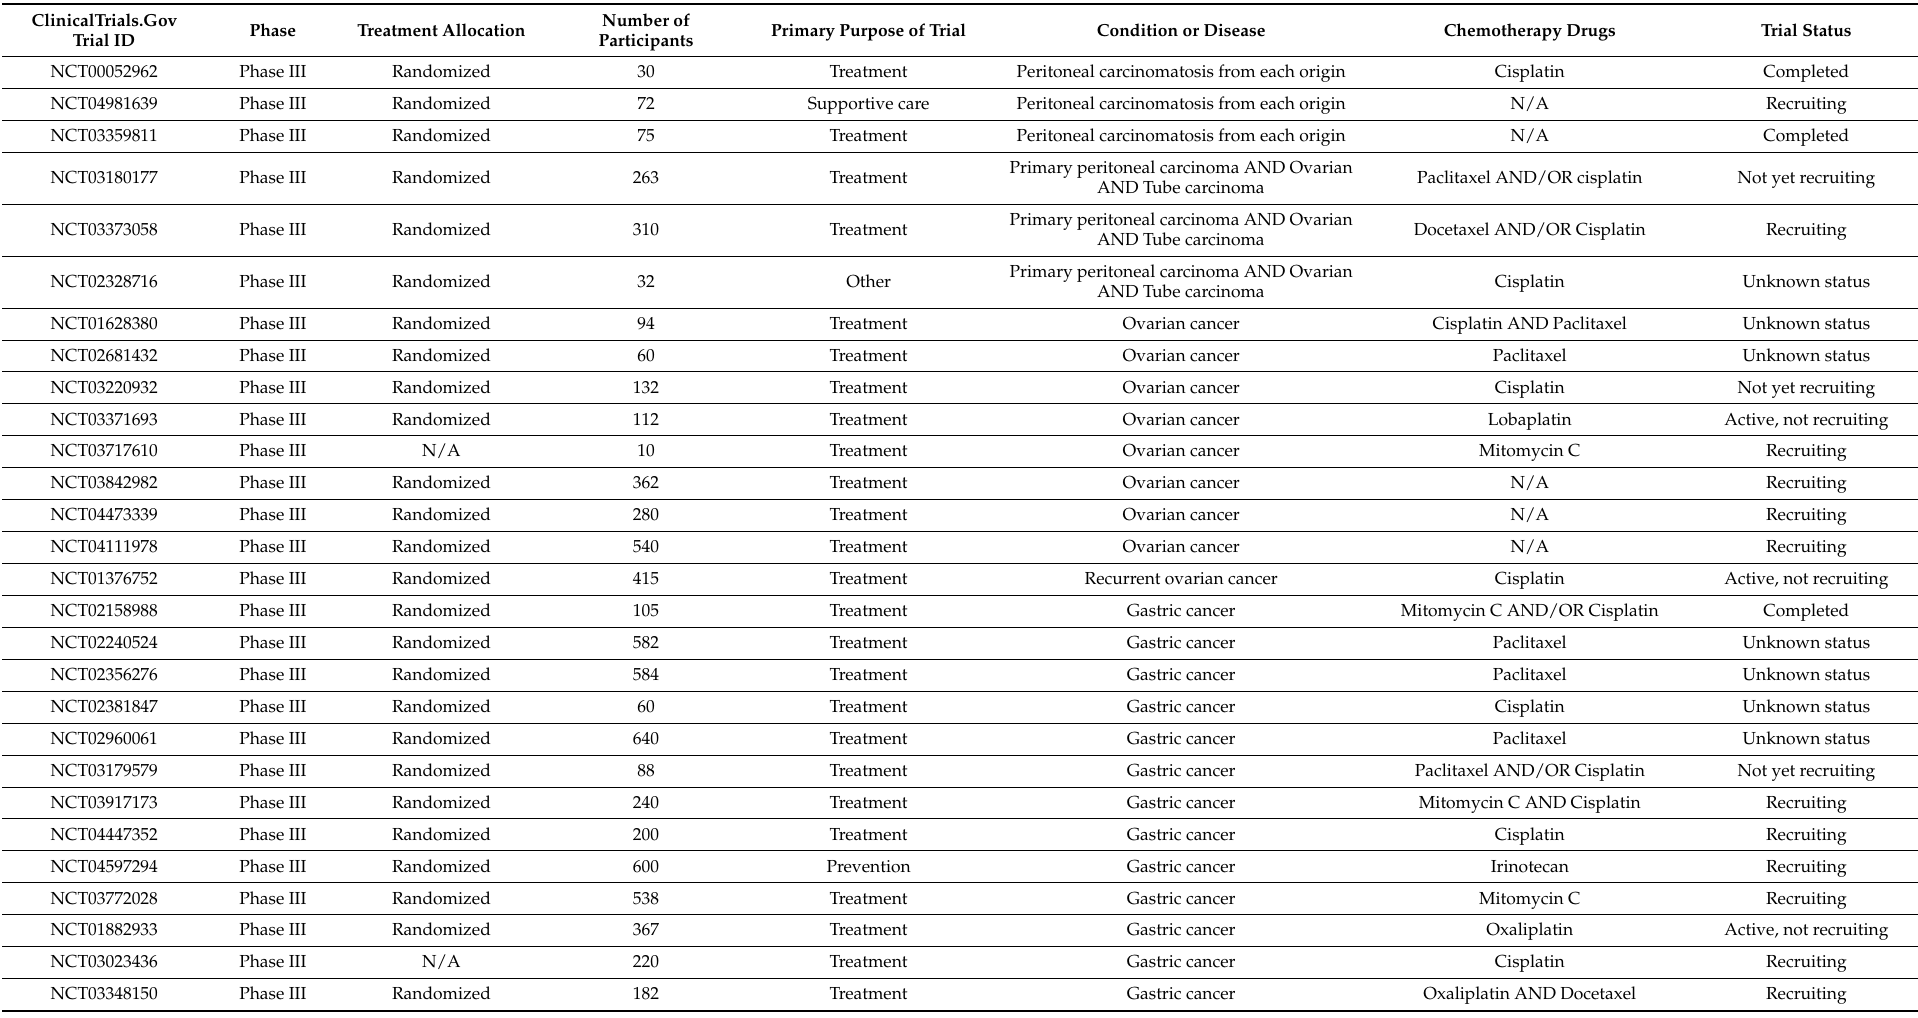
Table 3. Ongoing phase III and IV